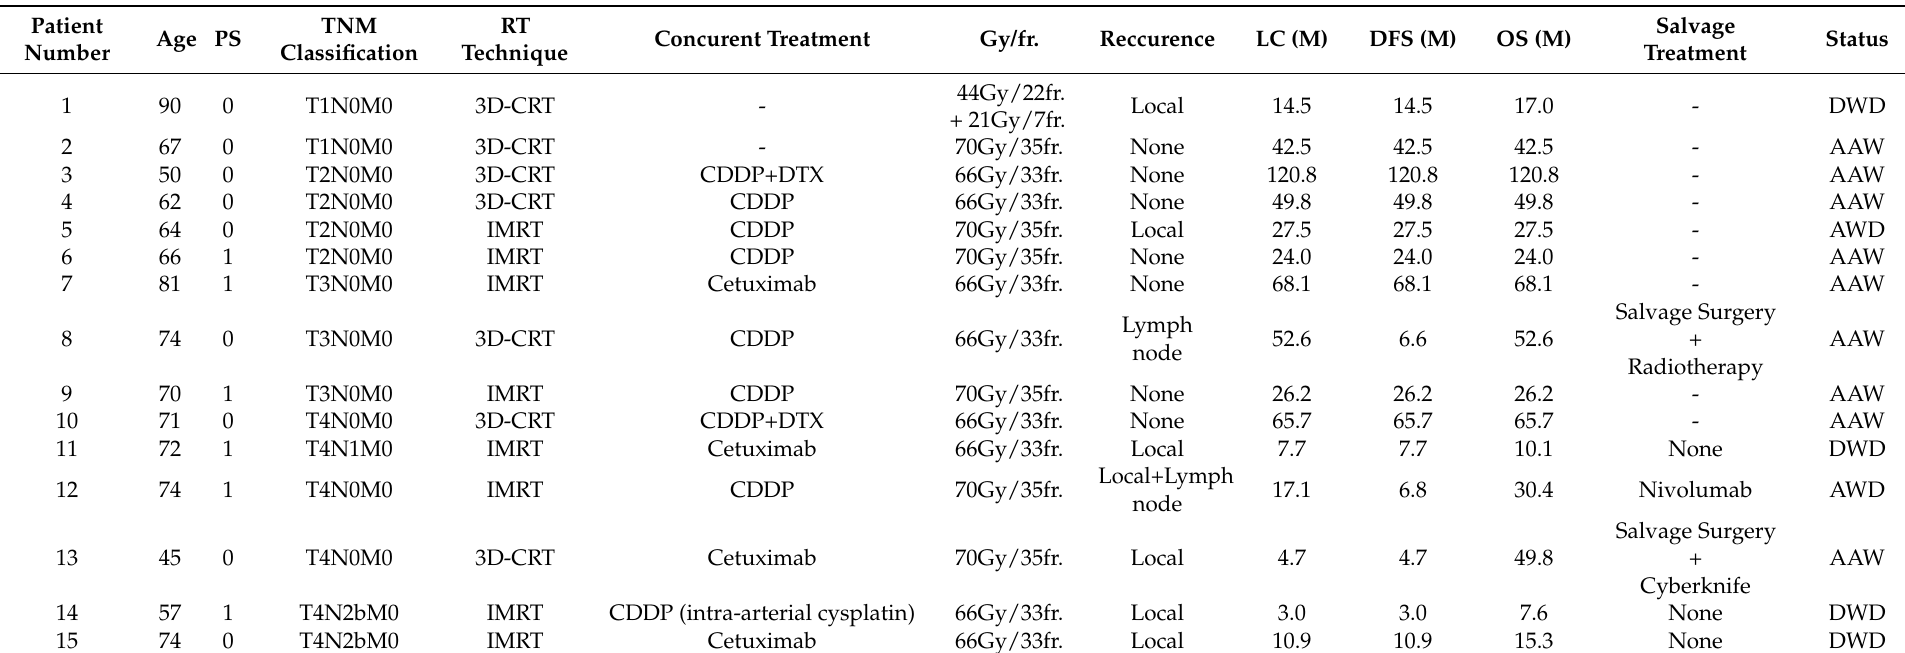
Table 2. Detailed patient